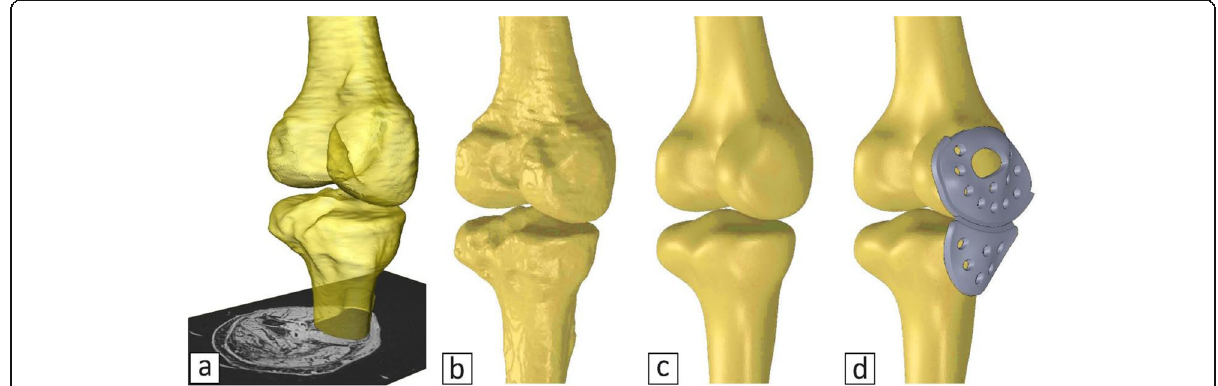
Fig. 2 a 3D surface rendered model (Amira software), b bones before smoothing, c smoothed bones using Meshmixer®, d knee bones with the implant